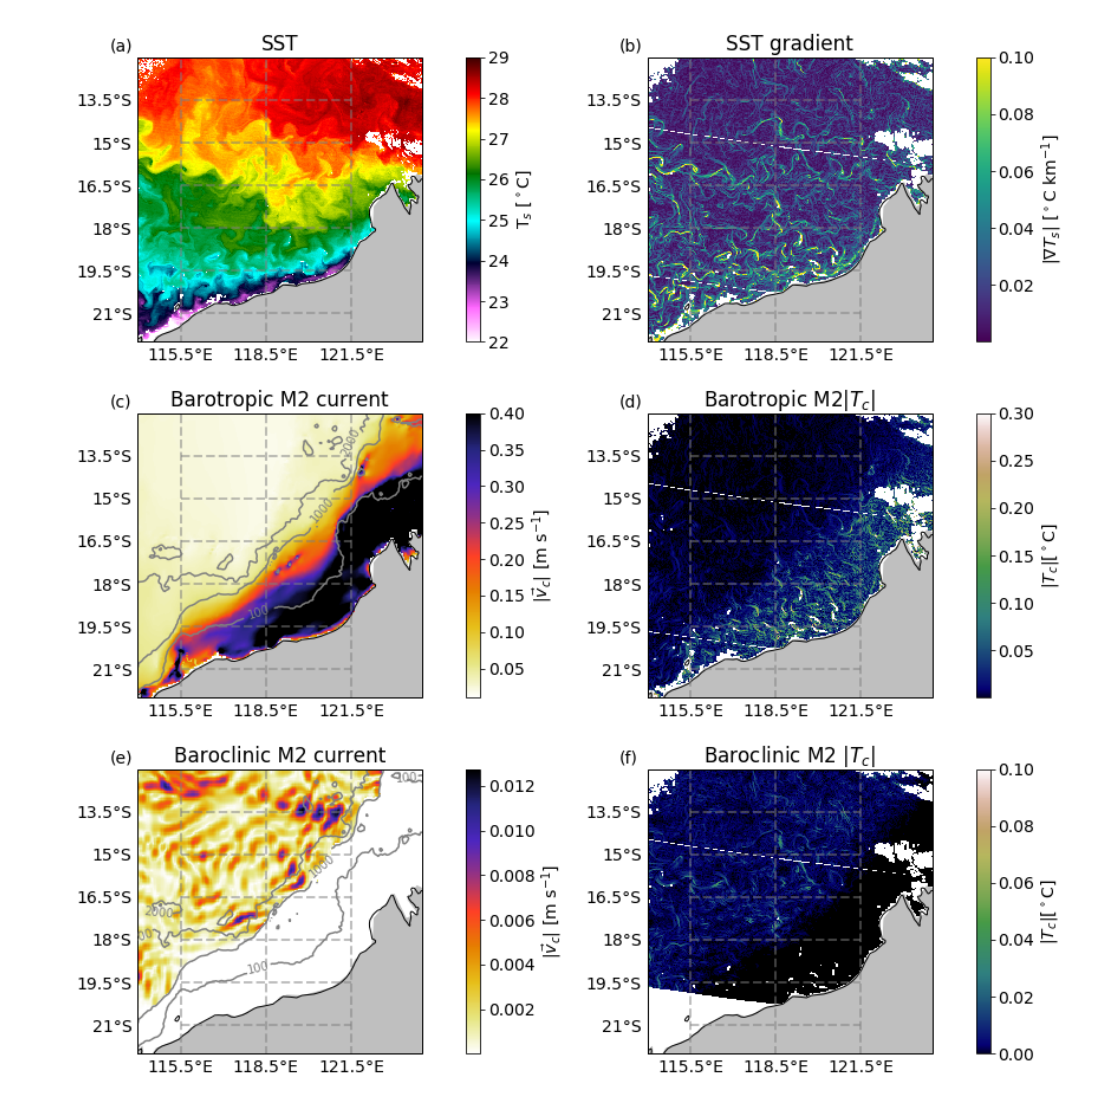
Figure 3. ( a ) SST captured by VIIRS on the 8 September 2016. ( b ) Sobel gradient of SST. Note that the SST field shown here is composed of three L2 granules. The gradient is computed for each granule individually. Thus, the representation of the gradient presents two scan lines with missing data that correspond to the boundaries of the granules. ( c ) M2 barotropic FES amplitude current. Gray contour correspond to the bathymetry. ( d ) Estimation of the amplitude of M2 signature on SST. ( e ) M2 baroclinic HRET amplitude current for areas with a bathymetry deeper than 1000m. Gray contour lines correspond to the bathymetry. ( f ) Estimation of the amplitude of M2 IW signature on